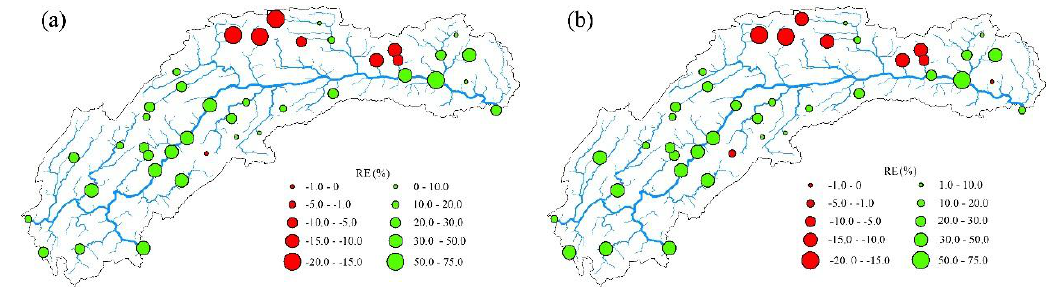
Figure 4. Precipitation relative errors (( a ) multi-year average annual precipitation; ( b ) multi-year average flood season precipitation).